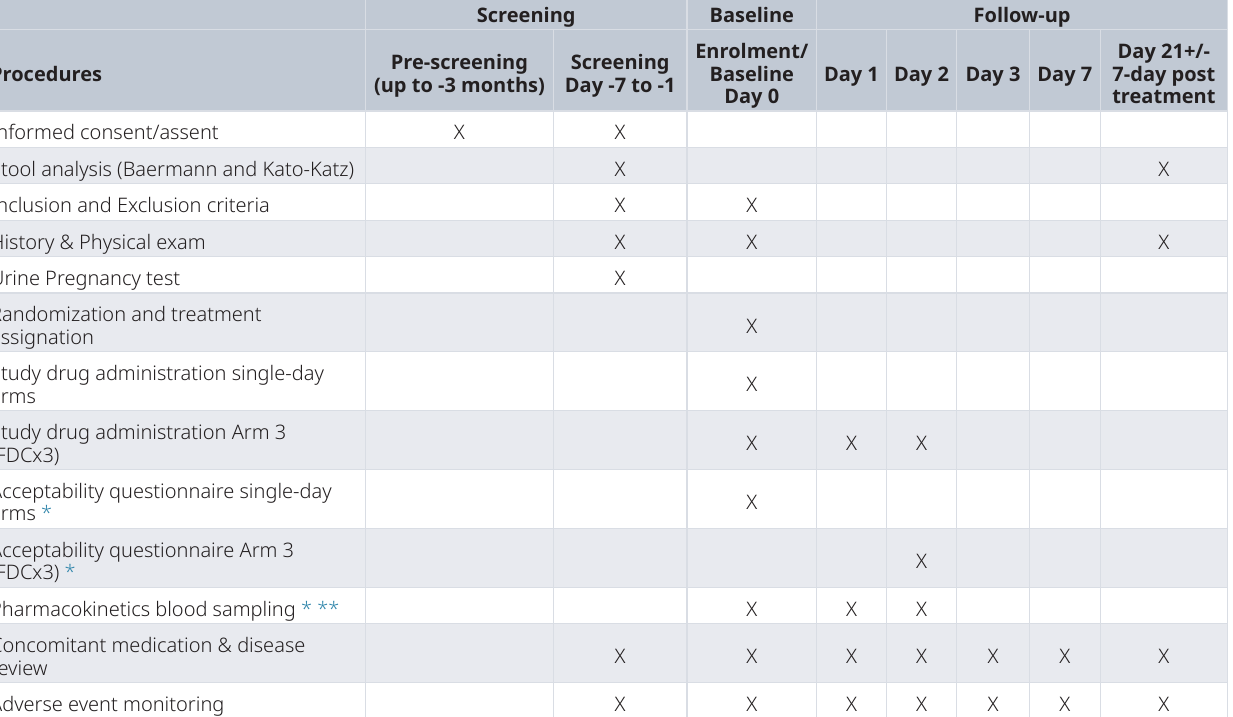
Table 1. Schedule of procedures for the phase II and III components of the ALIVE